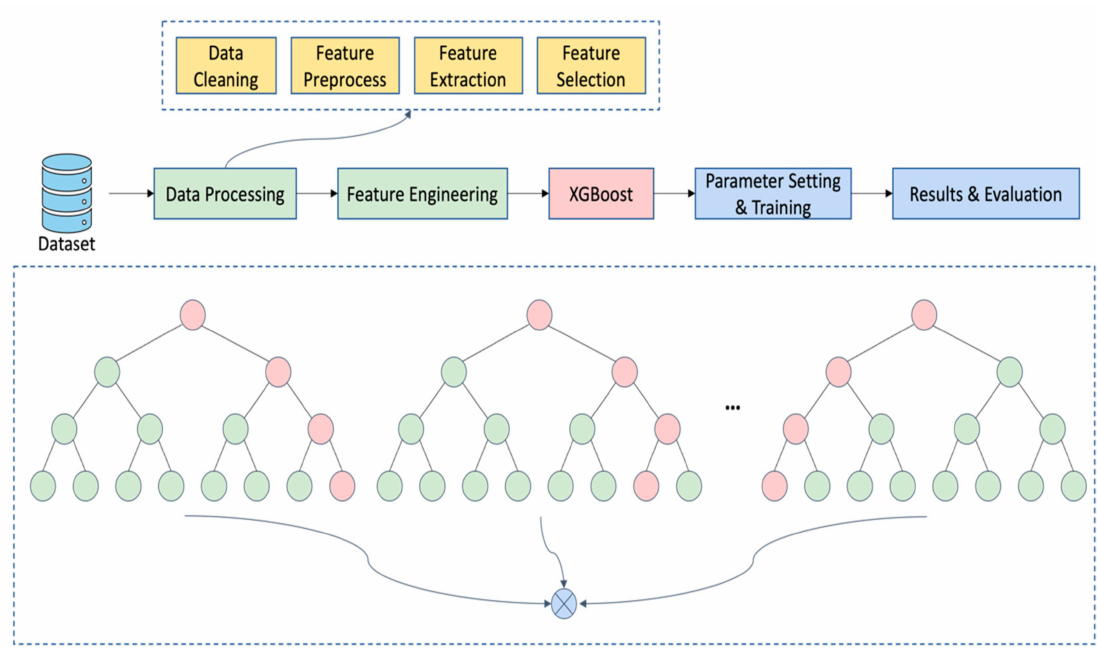
Figure 1. The process of the proposed data-intensive inventory forecasting models for cross-border e-commerce